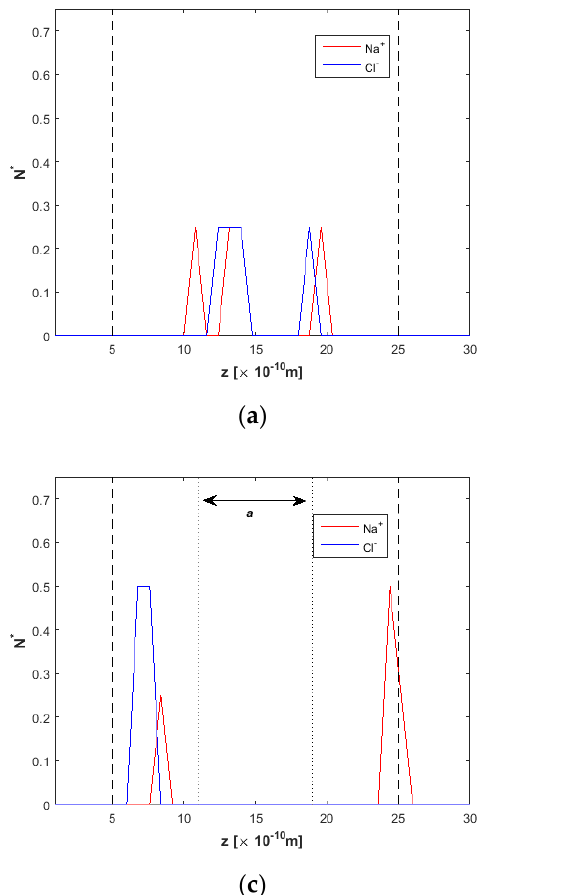
Figure 7. Ion concentration across the h = 2.0 nm nanochannel at various times of the simulation, F ext = 0.025 kcal / molÅ, ( a ) t = 5 ns, E = 0.0 V / Å, ( b ) t = 10 ns, E = 2.0 V / Å, ( c ) t = 15 ns, E = 2.0 V / Å, and ( d ) t = 20 ns, E = 2.0 V / Å. Dashed lines denote wall limits and dotted lines enclose the desired clean water region.